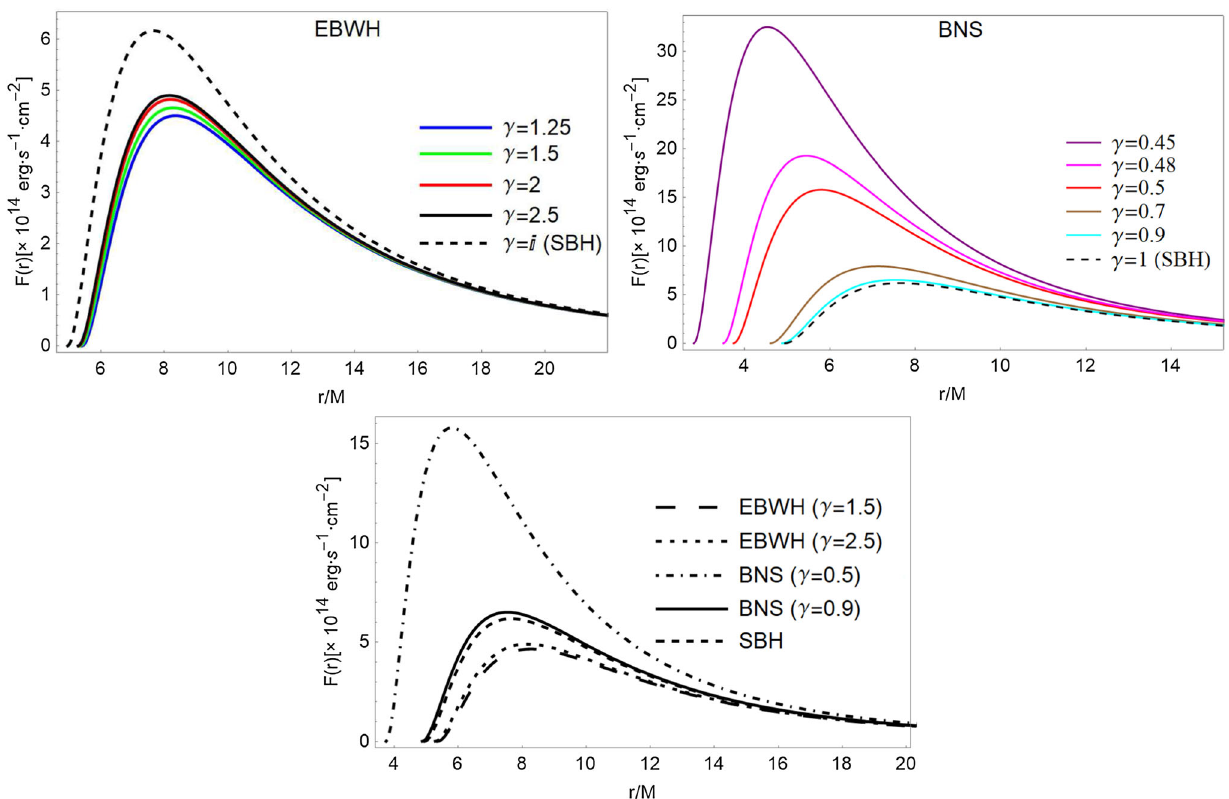
Fig. 5 The time averaged radiation flux F ( r ) for EBWH, BNS and SBH for different values of